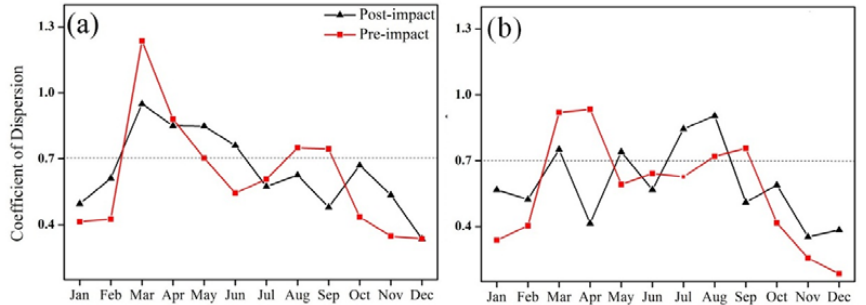
Figure 5. The variability of monthly streamflow in the JRW ( a ) North River reach; ( b ) West River reach.